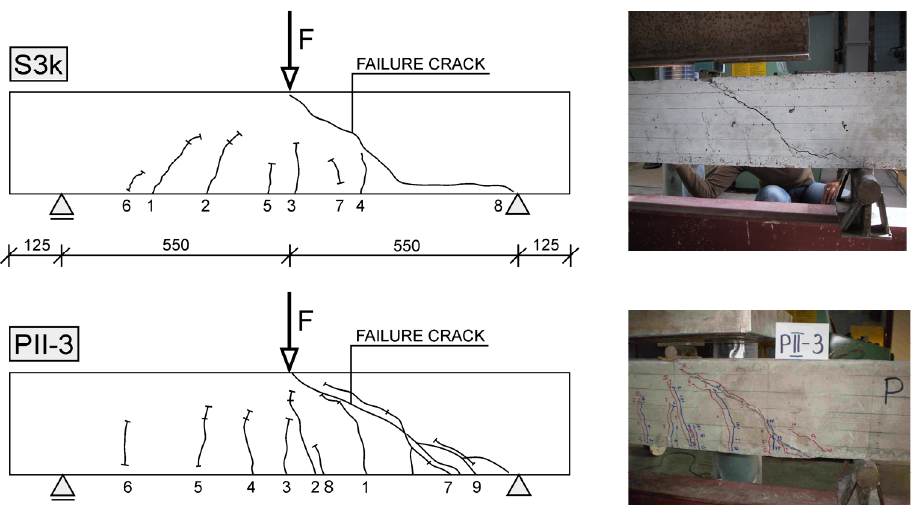
Figure 6. Cracks patterns for the slender beams S3k (2 ϕ 18) and PII-3 (2 ϕ 12).